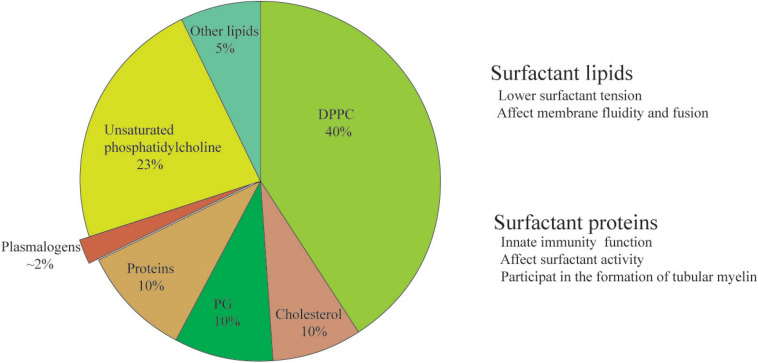
The composition and function of lung surfactant. The constitution of phospholipids% might be slightly different in different publications, and the discrepancy might be due to differences in the source (animal species) and the method of extraction (either from lavage or from whole minced tissue). Plasmalogen, a minor yet bioactive ether phospholipid of lung surfactant, is the ethanolamine and choline phospholipids vs. its ester counterpart.